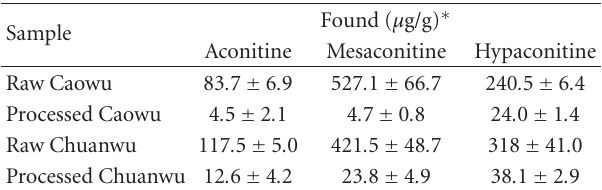
Table 3: HPLC analytical of raw and processed Caowu and Chuan- wu samples.